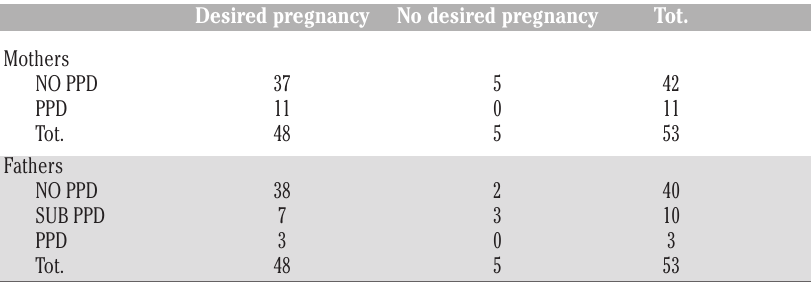
Table 4. Comparison between parents who desired the pregnancy and parents who not desire it.